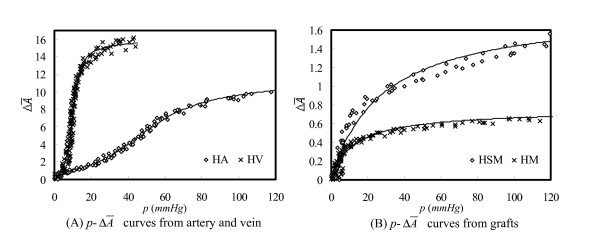
Experimental data points and regressed results (λz= 1.4, data from HA1, HV1, HSM1 and HM1).